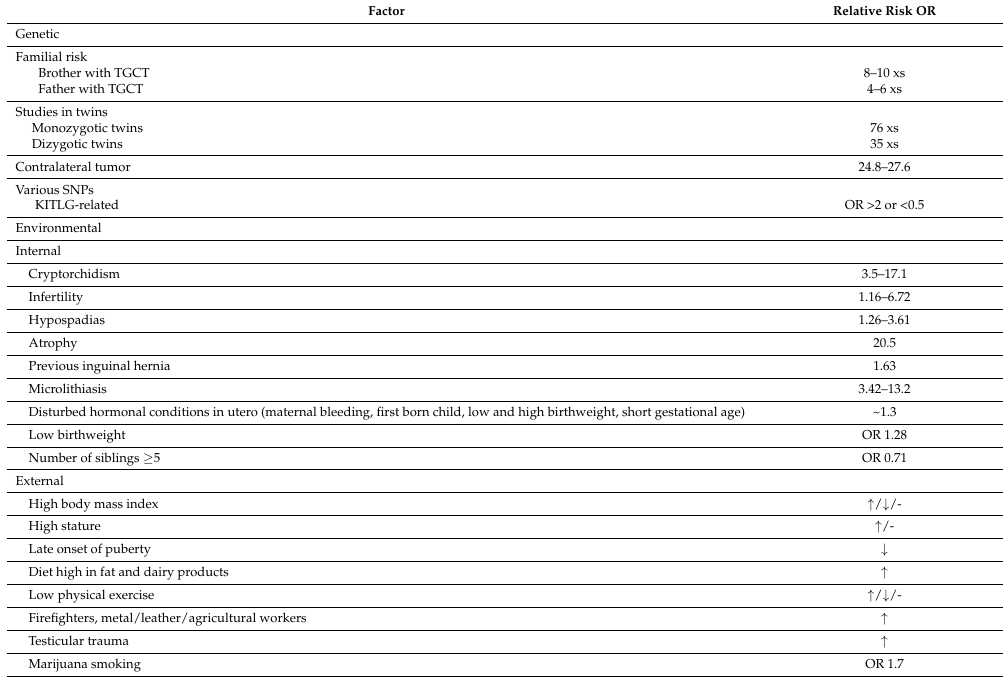
Table 2. Genetic and environmental risk factors for germ cell